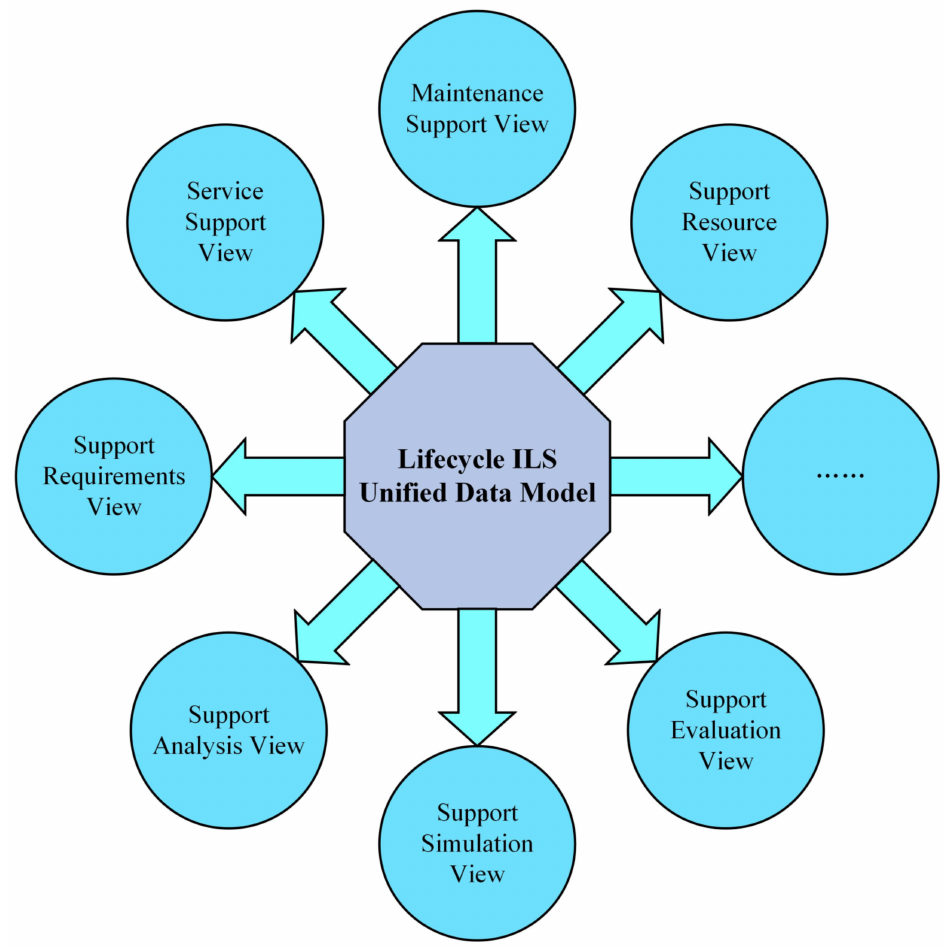
Figure 11. Different views of the Lifecycle ILS unified data